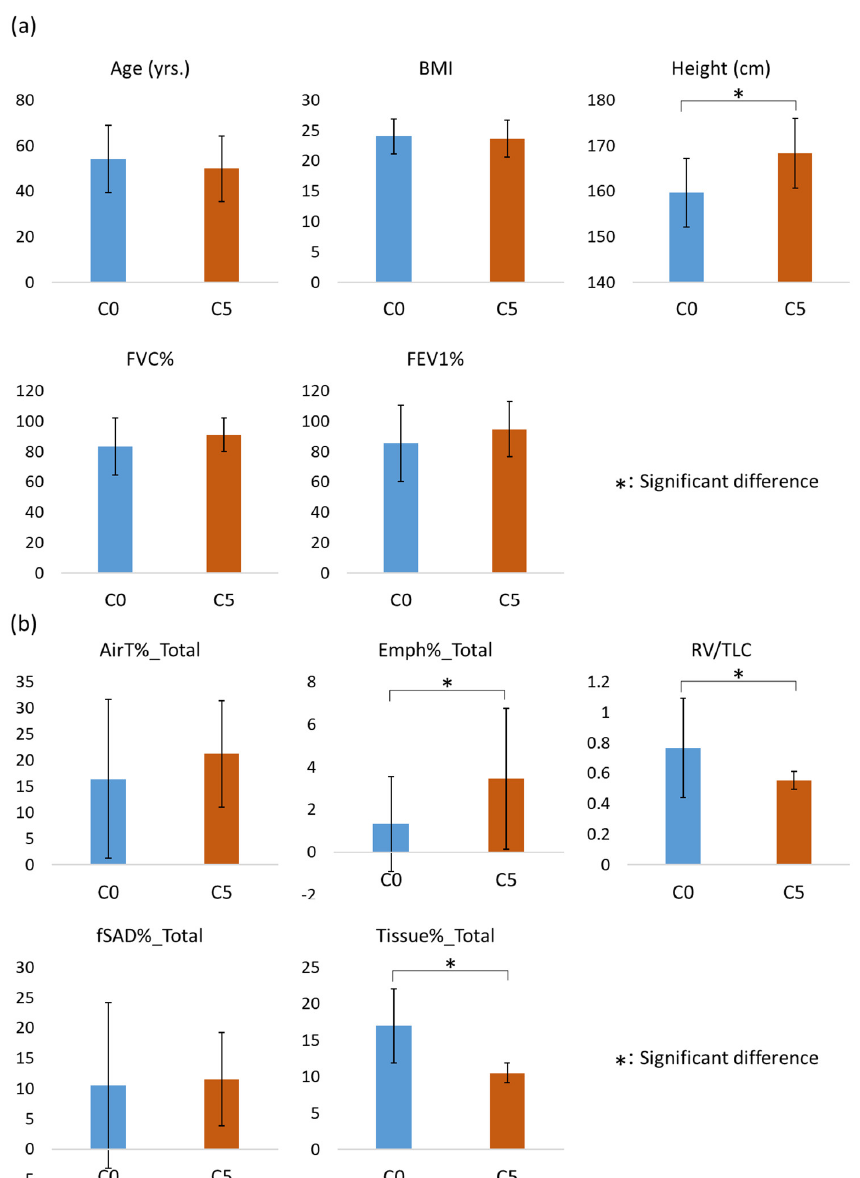
Figure 4. ( a ) Comparison between the clinical variables of C0 and C5. ( b ) Comparison between the imaging-based variables measured at total lung capacity of C0 and C5. The differences between the means of independent groups were analyzed by Welch’s ANOVA with the Games–Howell method for post hoc pairwise tests and the significance level was set as 0.05.